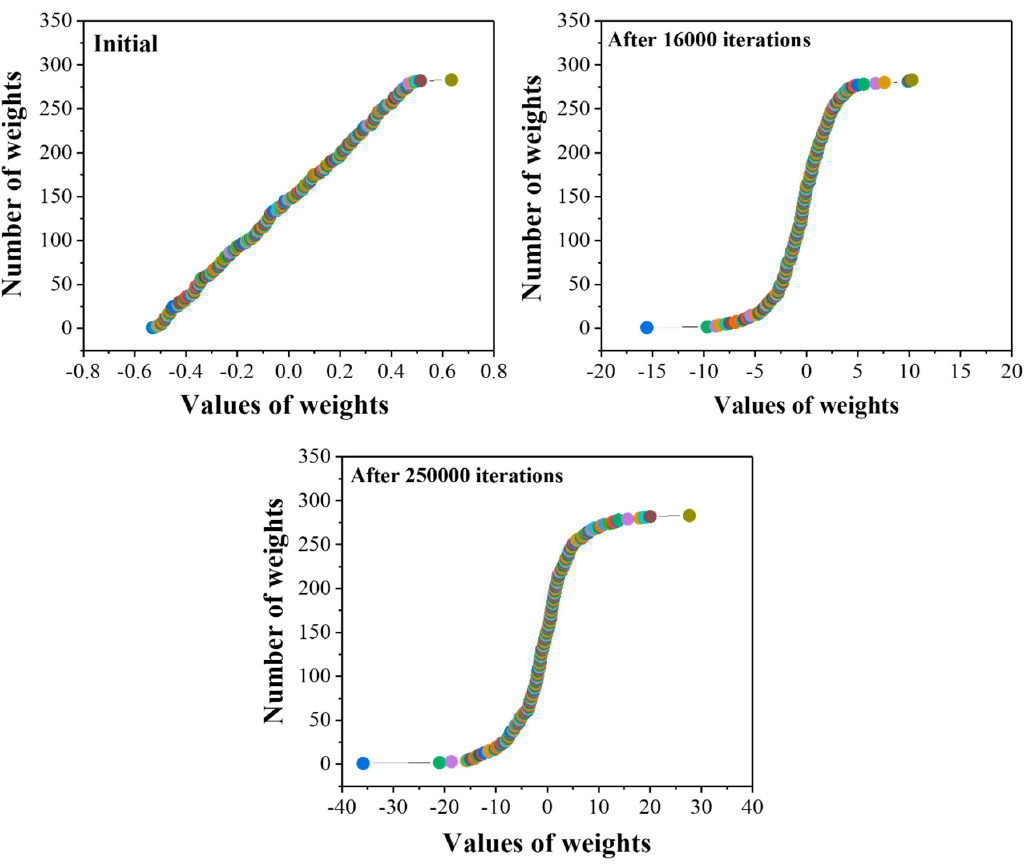
Figure 3. The distribution of weights as a function of iterations.